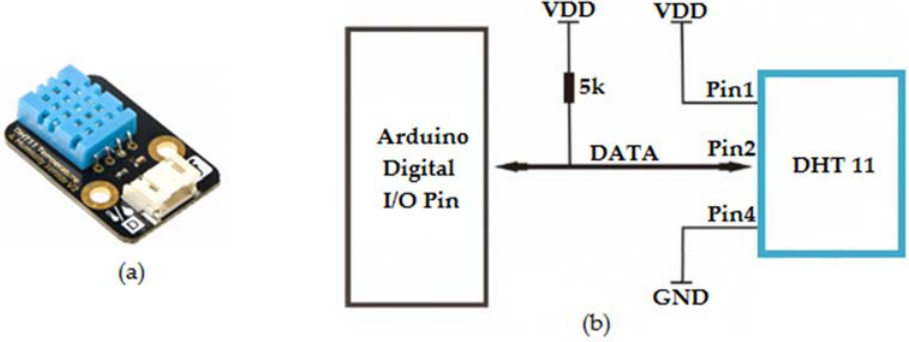
Figure 3. Temperature and humidity sensor. ( a ) DHT11; ( b ) circuit diagram.